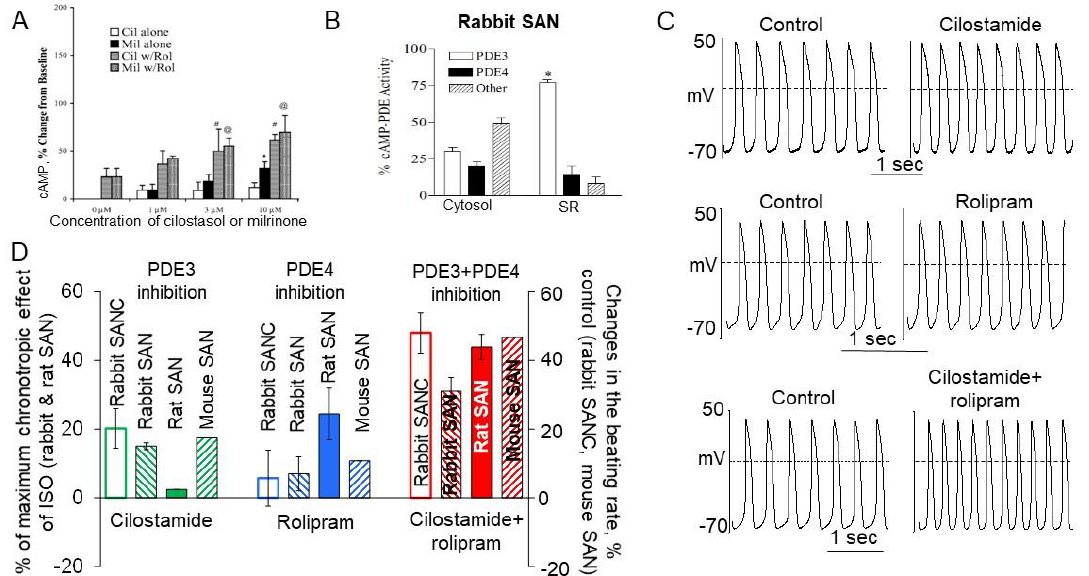
Figure 4. Dual PDE3 + PDE4 inhibition increases spontaneous beating rate of isolated SANC and intact SA nodes in a synergistic manner. ( A ) Inhibition of PDE4 with rolipram (1 µmol/L) in combination with PDE3 inhibitors cilostazol or milrinone (3 or 10 µmol/L) causes synergistic increases in cAMP levels in rabbit ventricular myocytes. # p < 0.05 vs. the additive effects of rolipram and cilostazol alone. @ p < 0.05 vs. the additive effects of rolipram and milrinone alone (modified from [91]). ( B ) Distribution of PDE3 and PDE4 activities in SR-enriched and cytosolic fractions in rabbit SA node, * p < 0.001 vs. PDE4 or ‘ other ’ PDE activity ( A , B with permission from [91]). ( C ) Representative recordings of APs of intact rabbit SANC prior to and during inhibition of PDE3 (top, cilostamide 0.3µmol/L) or PDE4 (middle, rolipram 2 µmol/L) alone or dual PDE3 + PDE4 inhibition (bottom) (from [11]). ( D ) The positive chronotropic effect produced by PDE3 or PDE4 inhibition alone or dual PDE3 + PDE4 inhibition in isolated rabbit SANC (cilostamide 0.3 µmol/L and rolipram 2 µmol/L, from [11]) or intact rabbit SA node (cilostamide 0.3 µmol/L and rolipram 10 µmol/L; graphic modification from [93]) or intact mouse SA node (cilostamide 0.3 µmol/L and rolipram 1 µmol/L; graphic modification from [94]) or intact rat SA node (cilostamide 0.3 µmol/L and rolipram 1 µmol/L; graphic modification from [95]).